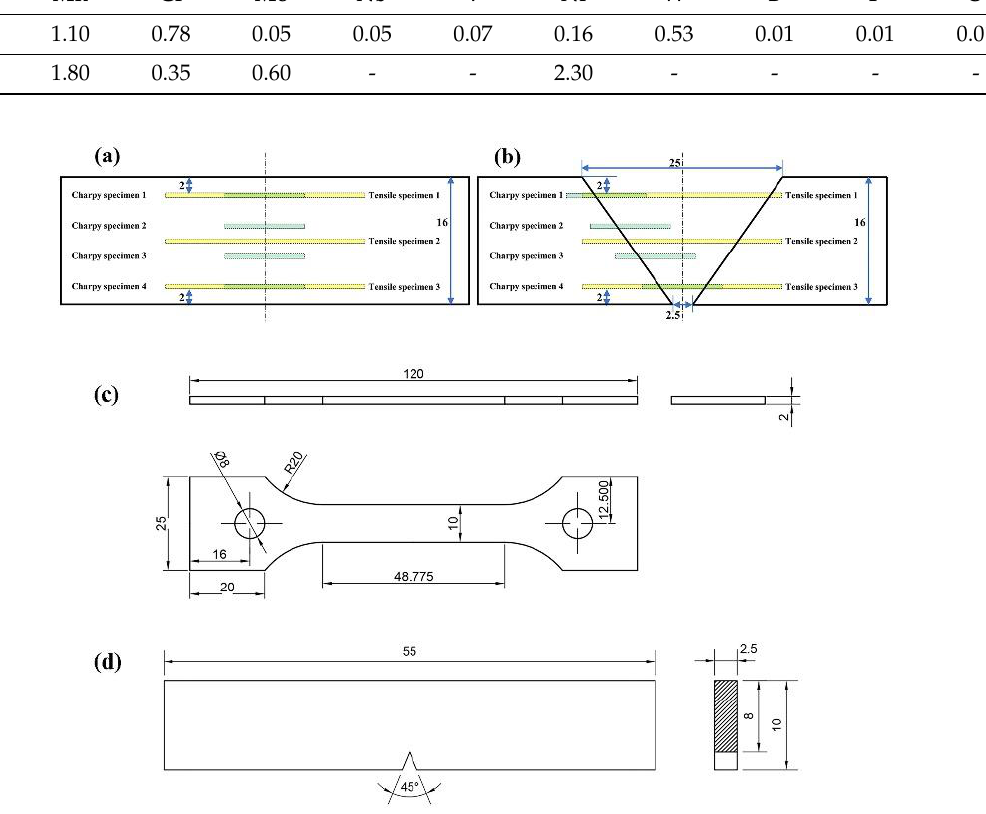
Figure 1. Dimensions of grooves shape ( a ) LBW joint ( b ) SMAW joint ( c ) Tensile specimen ( d ) Charpy specimen (Unit: mm). Table 1. Composition and content of chemical elements in HSLA Q890 and X90 filling wire (wt.%).